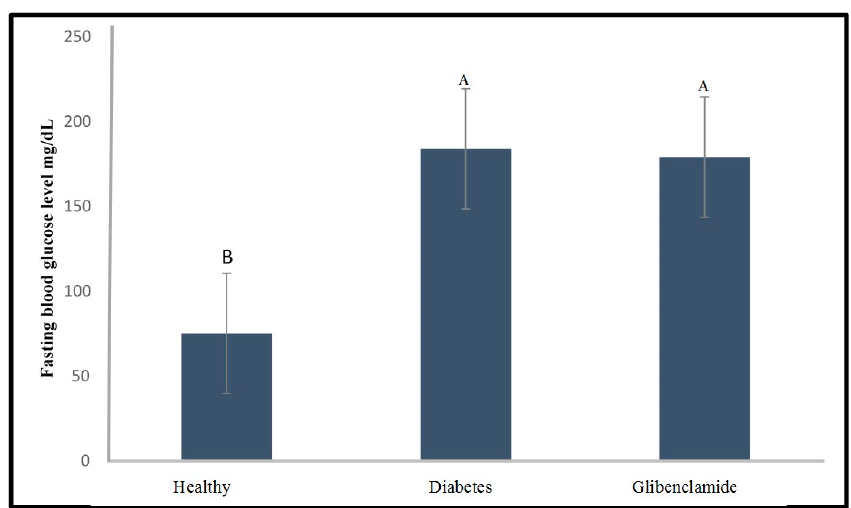
Figure 6. Fasting blood glucose level of the healthy, diabetes, and glibenclamide injected zebrafish (glibenclamide dose = 1.5 mg/kg) at 48 h after the alloxan injection. Different capital letter indicates significant difference ( p < 0.05) among the values, n =10.